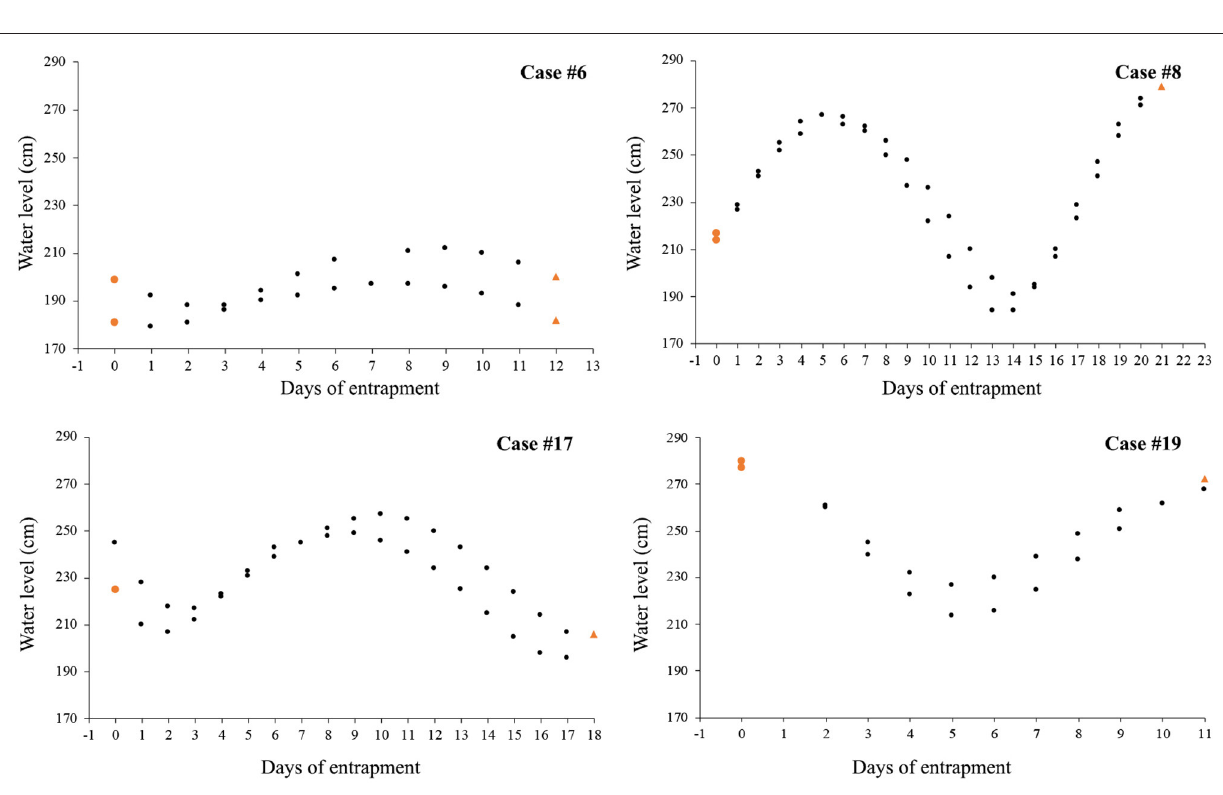
FIGURE 3 | Variation over time of water level (in cm) at high tide after killer whales first appeared at the entrapment site; tidal data are only shown for the four cases in Category 1 for which entrance day could reliably be identified (colored circles and triangles indicate water level on the day of killer whales’ entry and departure,